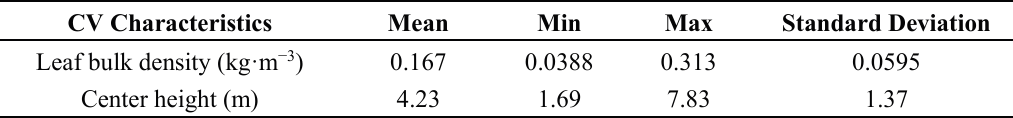
Table 2. Main characteristics of the 35 Calibration